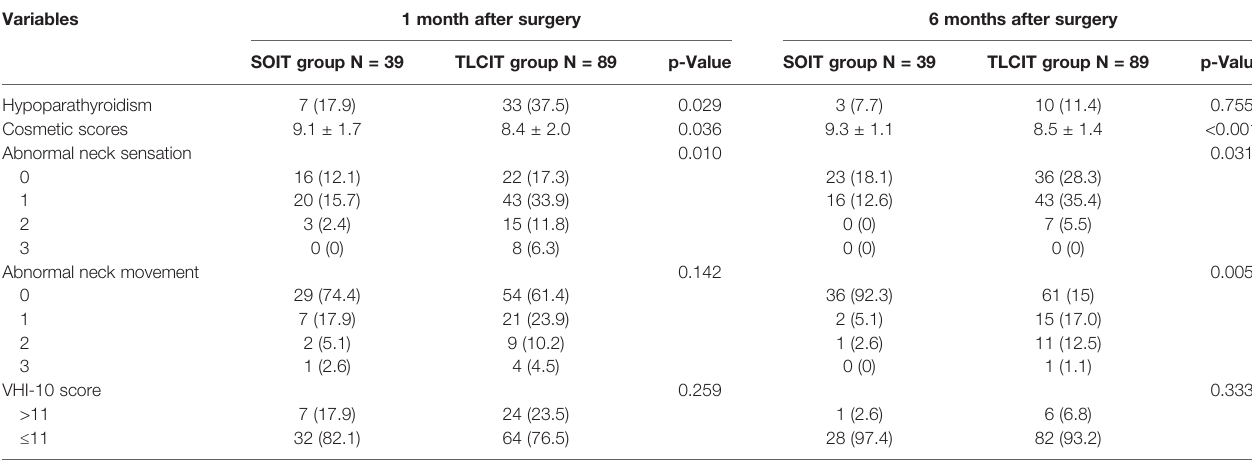
TABLE 2 | The comparison of 1-month and 6-month follow-up outcomes in SOIT and TLCIT groups.